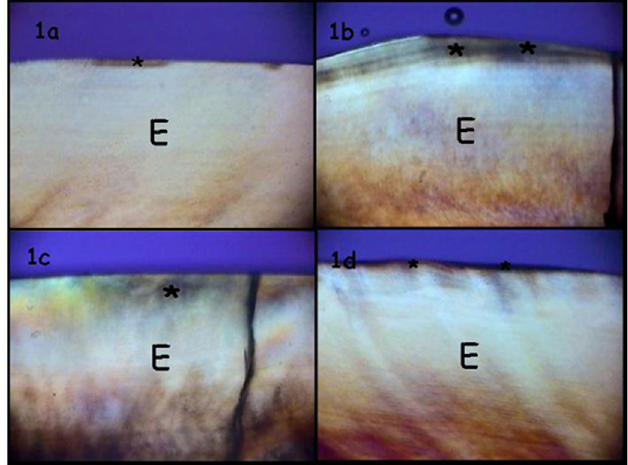
Fig. 1. Polarized light microscopy (×20): specimens subjected to artificial saliva (1a); 10% carbamide peroxide (1b); 10% carbamide peroxide + 0.11% fluoride (1c) and 10% carbamide peroxide + 0.5% fluoride (1d). Demineralization areas (asterisks) are seen below enamel surface in all specimens (E-